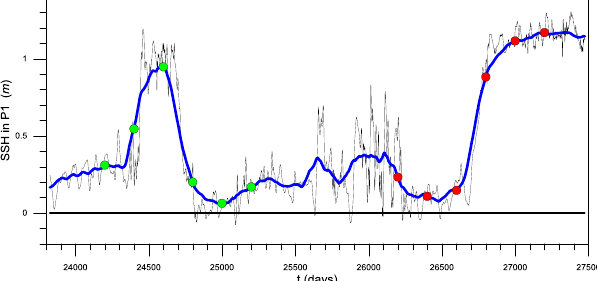
Fig. 8. SSH at P1 for the reference interval (black line: total signal; blue line: low-frequency signal). The SSH snapshots corresponding to the green/red dots are shown in Fig.